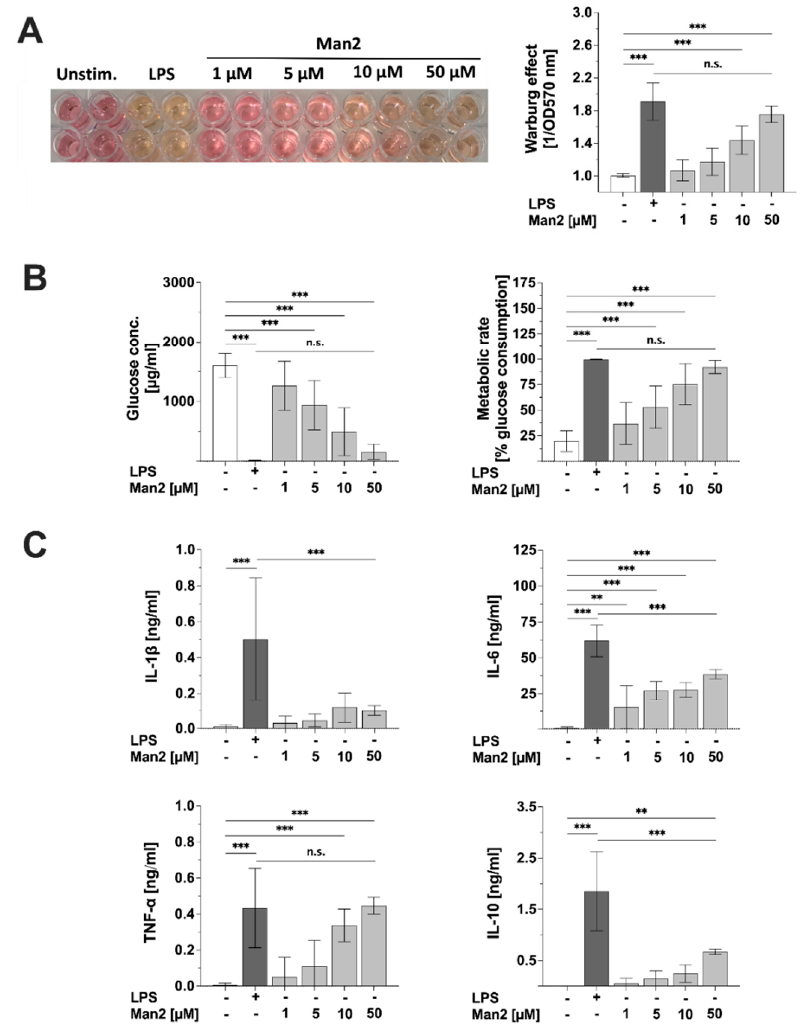
Figure 7. Effect of Man2 on glucose metabolism and cytokine secretion from BMDCs. BMDCs derived from C57BL/6 mice (1 × 10 6 cells/mL) were stimulated with either 1.0 to 50 µ M Man2 or 10 µ g/mL of LPS. ( A ) After 72 h of stimulation, the induced Warburg effect was quantified both optically and photometrically. In addition, ( B ) glucose consumption and metabolic rate and from culture medium were determined, whereas ( C ) cytokine concentrations in culture supernatants were determined by ELISA. Data are mean values ± SD of four independent experiments. ** p < 0.01, *** p < 0.001 in Tukey’s HSD multiple comparison test. n.s. = not significant;